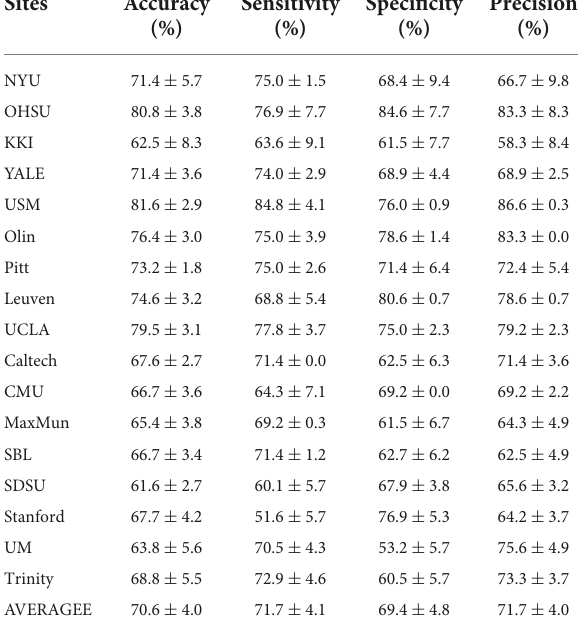
TABLE 3 Classification performance of our proposed method on single-center